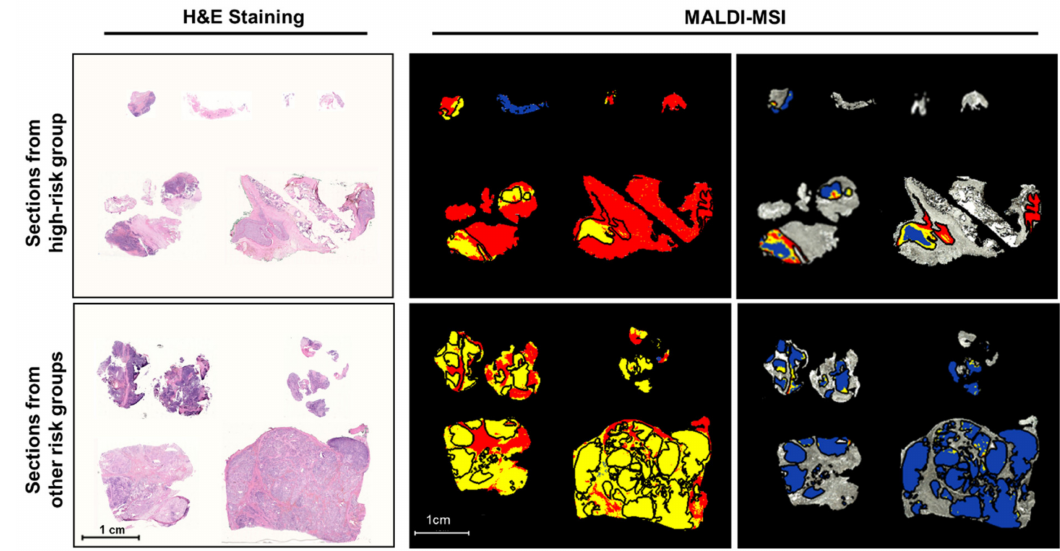
Figure 1. MALDI imaging identifies high-risk neuroblastomas by heterogeneous peptide signatures in tumor cell-rich regions. Sections from primary neuroblastomas with high or other risk classifications are shown with hematoxylin and eosin (H&E) staining for tissue section orientation in segmentation maps of MALDI-MSI analysis. Segments (indicated by different colors) represent different proteomic clusters generated by bisecting k-means clustering. Black lines surround tumor areas with >80% tumor cell content (annotated by the reference pathologist). Signatures derived from segmentation clustering across the whole tissue section are shown in the middle column and peptide signatures derived only across the tumor cell-rich areas in the sections shown on the right. Colors represent the same proteomic clusters in the 2 images in the middle column and the 2 images in the right column, but not between the middle and right images.